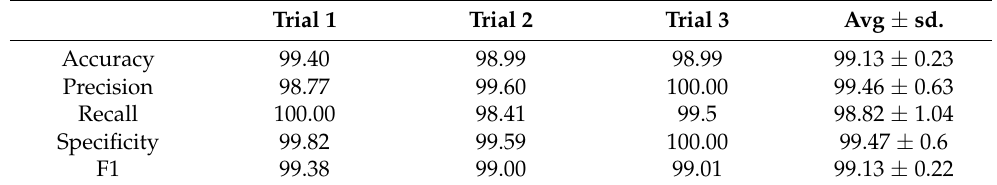
Table 4. Classification results (expressed as a percent) obtained on the CT dataset with a split of 80:20. Trial 1 Trial 2 Trial 3 Avg ± sd.